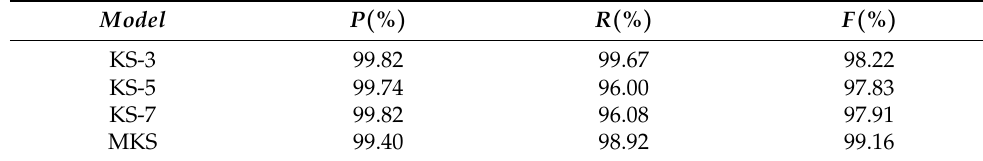
Table 5. Model performance when using dilated convolution with different convolution kernel